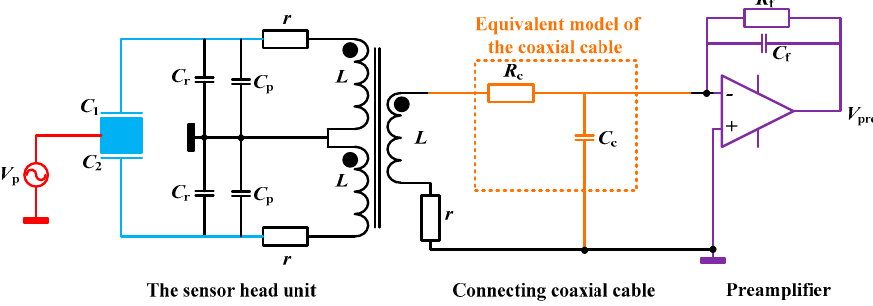
Figure 2. The signal model of the transformer and preamplifier with a coaxial cable.